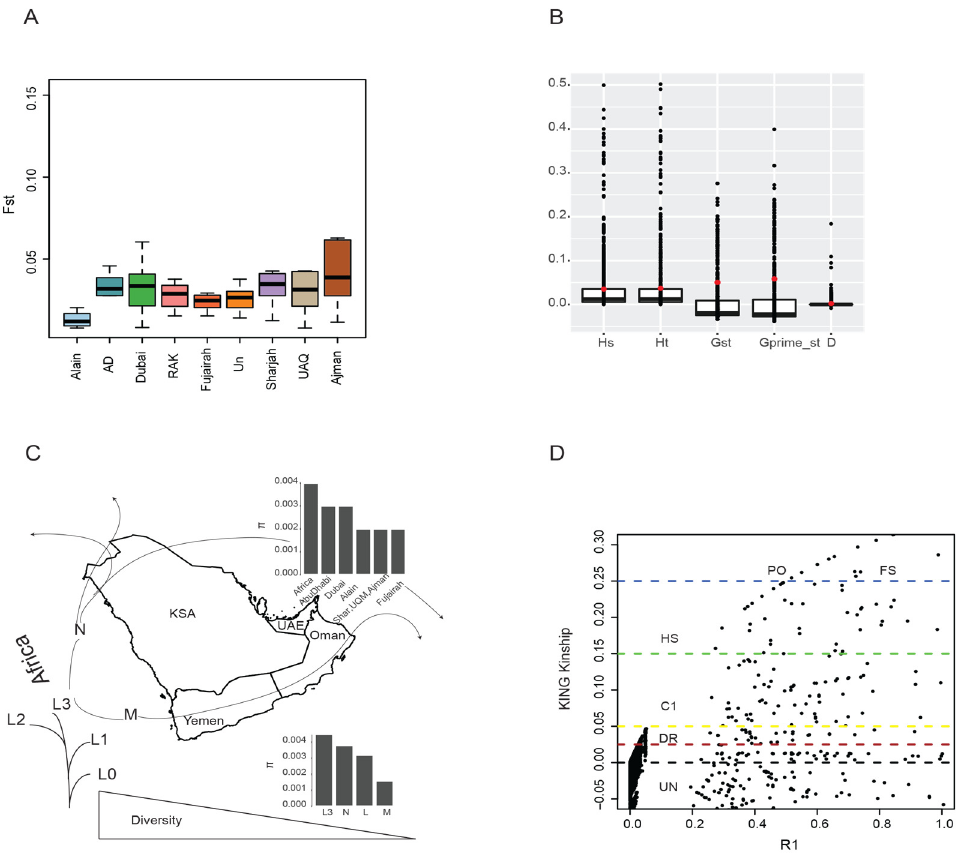
Figure 4. Population di ff erentiation and diversity. ( A ) Population di ff erentiation (Fst) per city of the UAE. ( B ) Population di ff erentiation statistics depicted by Hs, Ht, Gst, G’st, and D. ( C ) A map showing the expected gradient of diversity decrease along the out of Africa passage. Diversity estimates for Africa in comparisons to other UAE cities as well as L haplogroup (and L3) to M and N haplogroups. ( D ) Consanguinity statistics plotted as a KING robust kinship matrix for the di ff erent individuals, where the degree of relatedness is shown as UN (unrelated), DS (distantly related), C 1(first cousin), HS (half-sibs), PO (parents-o ff spring), and FS (full-sibs).